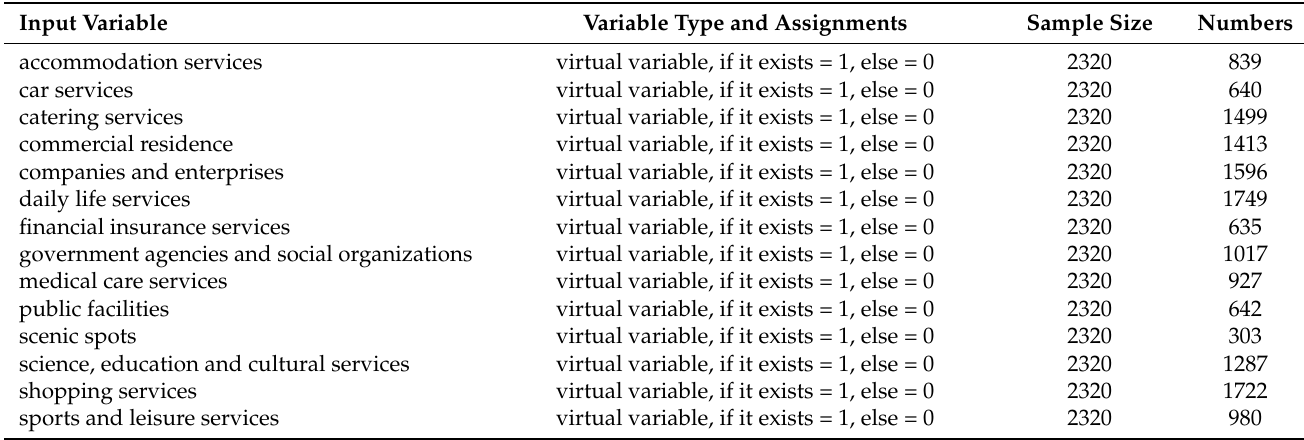
Table 1. The input variables of Apriori.